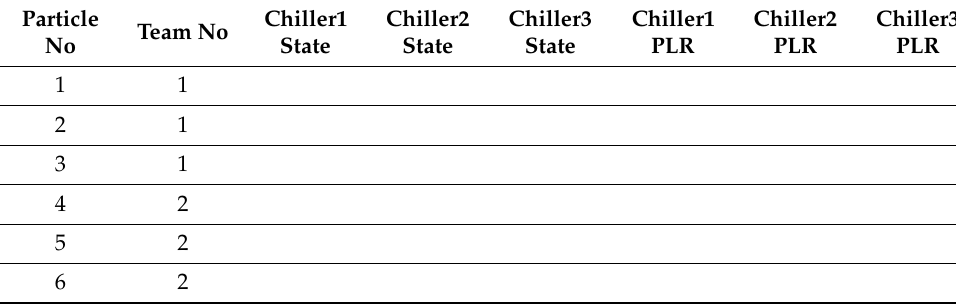
Table 1. Step 1: the particles are assigned to teams.